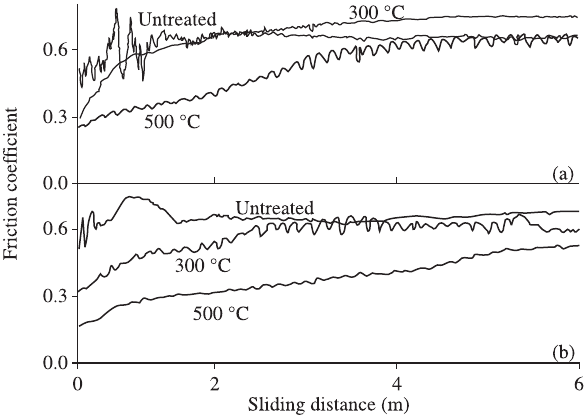
Figure 5. Friction coefficient profiles as a function of sliding distance for AISI 304 (a) and AISI 316 (b) untreated, and for samples nitrided at 300 and 500 °C.